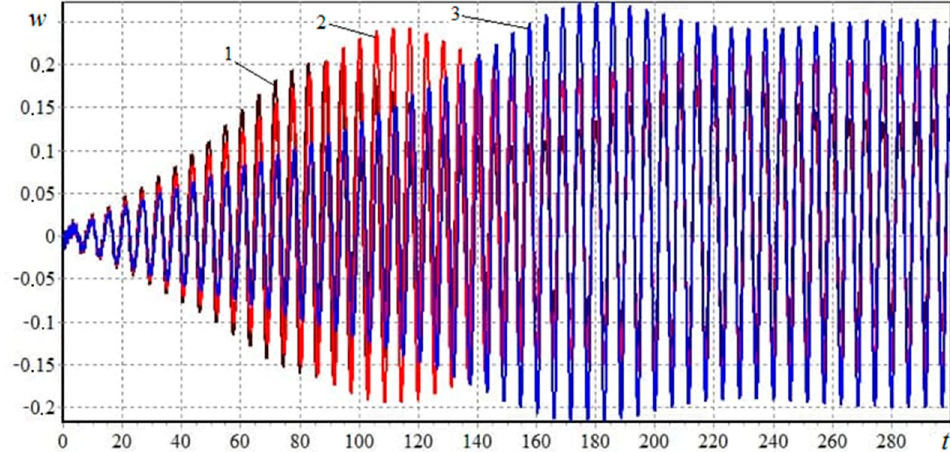
Figure 2. Time history of the deflection w for (1) A ij = 0.01, (2) A ij = 0.02, and (3) A ij = 0.03.